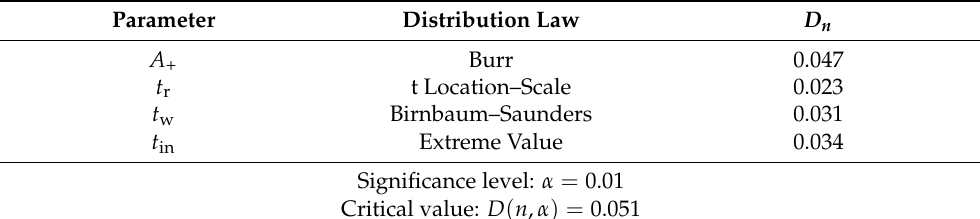
Table 2. K–S test for the selected distribution laws. Parameter